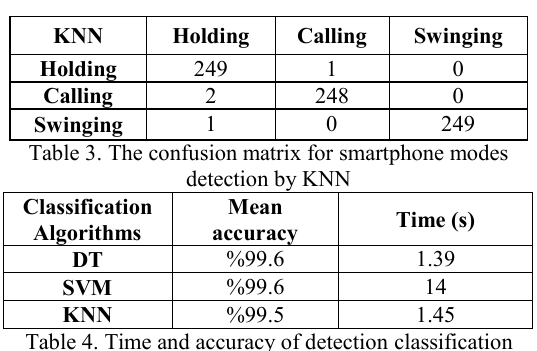
Table 2. The confusion matrix for smartphone modes detection by SVM.